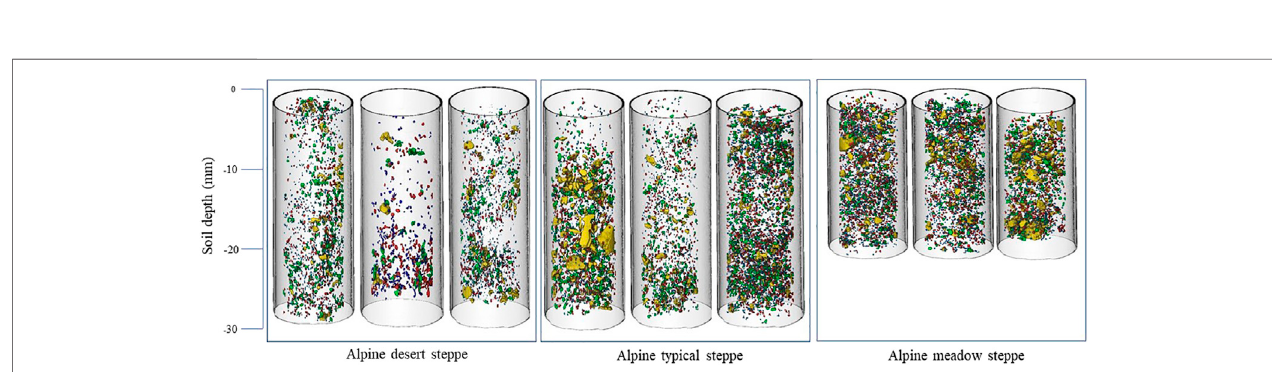
FIGURE 3 | 3-D visualization of rock fragments networks in the soil columns under alpine desert steppe (ADS), alpine steppe (AS), and alpine meadow (AM).